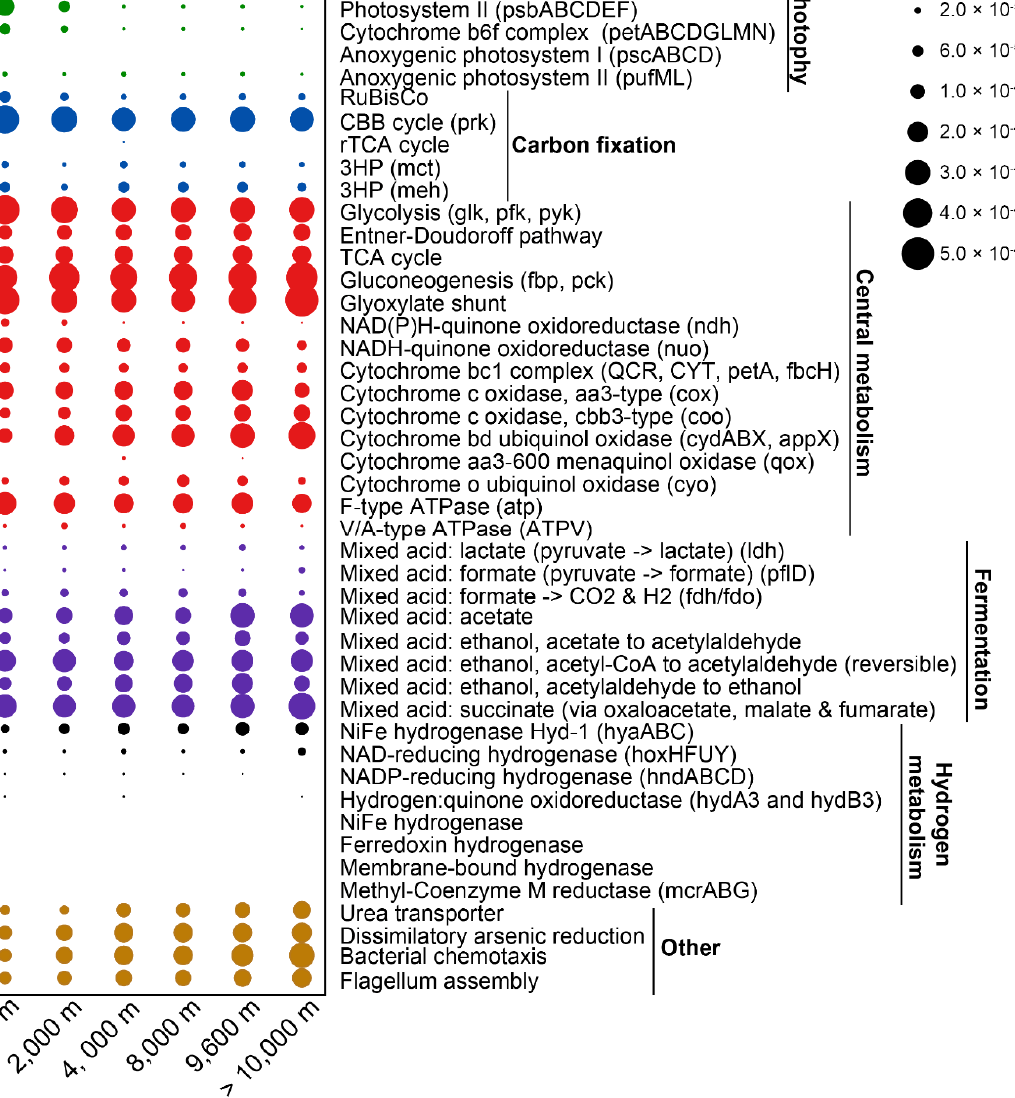
Figure 2. Distribution of major functional processes across different water depths in the Mariana Trench. The X ‐ axis indicates the different water layer samples were derived from. The y ‐ axis indicates the major selected functional processes involved in oxidative phosphorylation, carbon fixation, carbon degradation, hydrogen redox and other specific pathways. Distribution of these functional processes in each sample can be found in Figure S3.